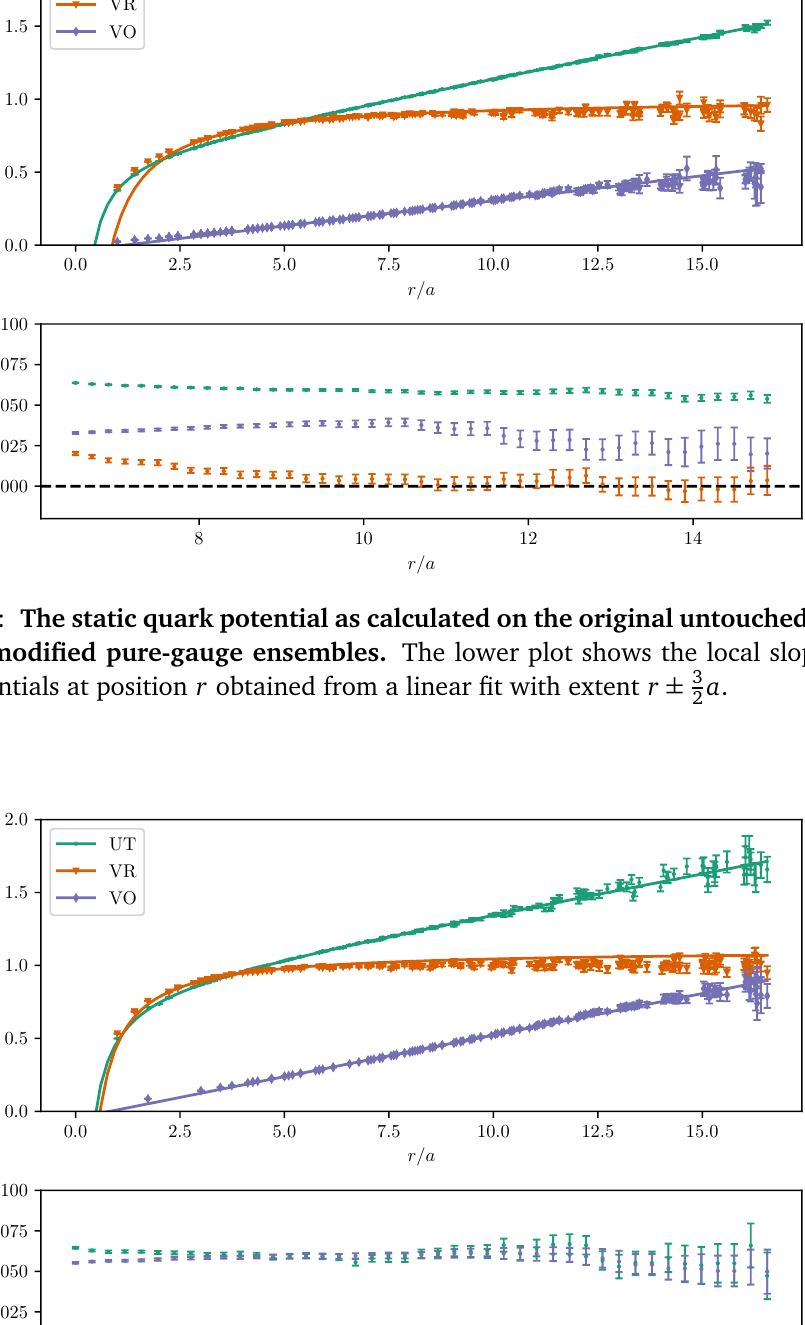
Figure 7: The static quark potential as calculated on the vortex-modified dynamical-fermion ensembles, corresponding to a pion mass of 701 MeV. Details are as in Fig. 6.